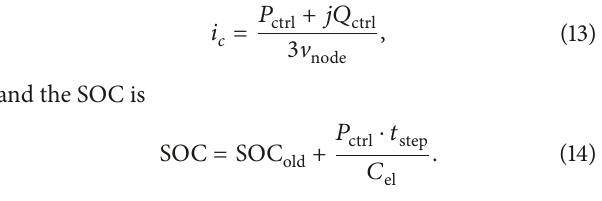
with the input current from the previous node 𝑖 voltage at the primary